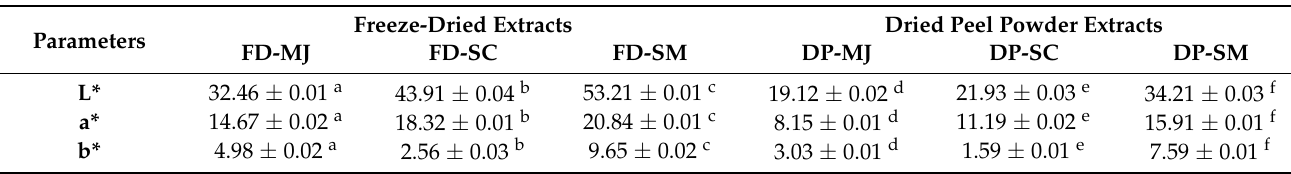
Table 1. Color analysis of freeze-dried (FD) and dried peel powders (DP) extracts of Myrciaria jaboticaba (DP-MJ and FD-MJ), Syzygium cumini (DP-SC and FD-SC), and S. malaccense (DP-SM and FD-SM). Freeze-Dried Extracts Dried Peel Powder Extracts Parameters FD-MJ FD-SC FD-SM